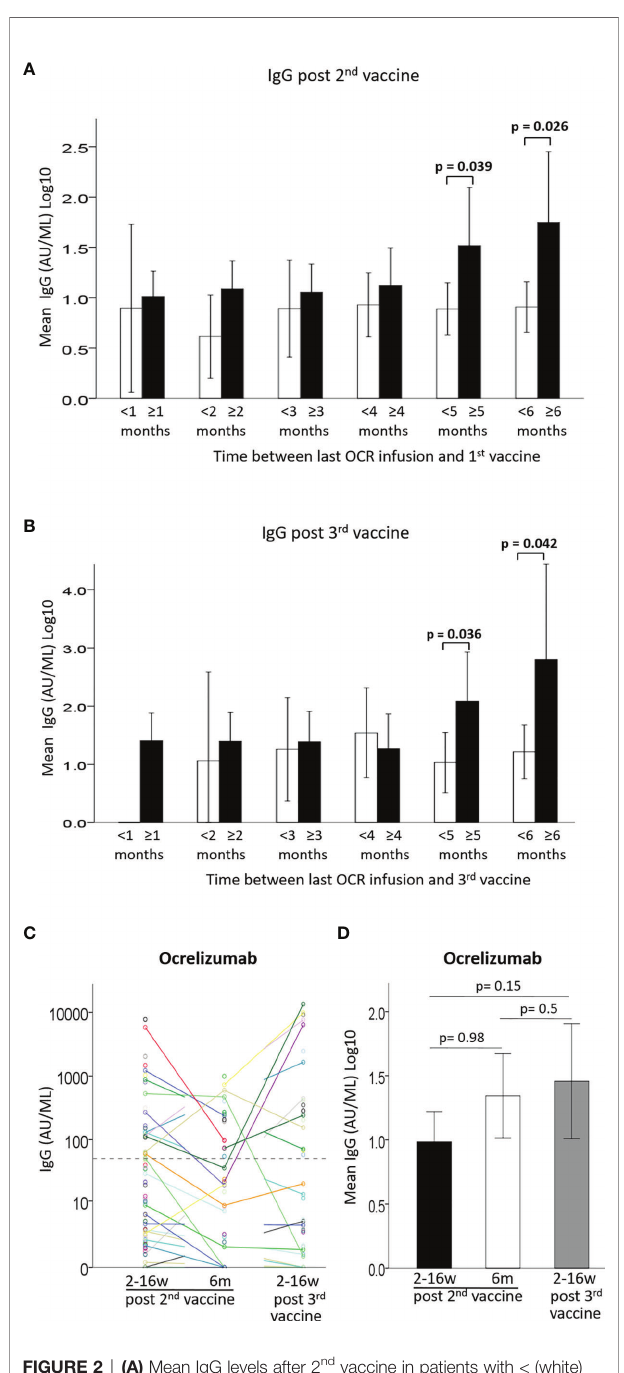
FIGURE 2 | (A) Mean IgG levels after 2 nd vaccine in patients with < (white) or ≥ (black) 1-6 months between last Ocrelizumab infusion and 1 st vaccine. (B) Mean IgG levels after 3 rd vaccine in patients with < (white) or ≥ (black) 1-6 months between last Ocrelizumab infusion and 3 rd vaccine. (C) IgG levels of Ocrelizumab-treated patients at 3 time-points: ≤ 3months and 6 months from 2 nd vaccine and ≤ 3 months from 3 rd vaccine. (D) Comparison of IgG levels in Ocrelizumab-treated patients at 3 time-points: ≤ 3months (N=89) and 6 months (N=38) from 2 nd vaccine and ≤ 3 months from 3 rd vaccine (N=43). Dashed horizontal grey line represents minimum seropositive border